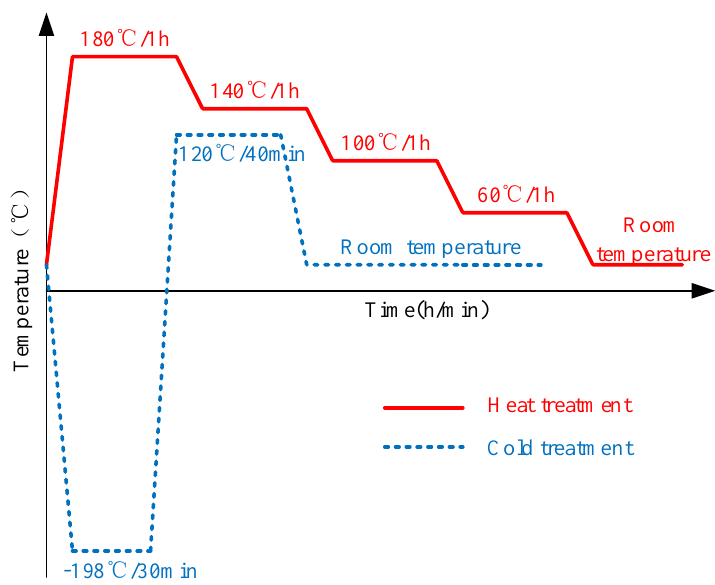
Figure 2. The processes of heat and cold post-treatment.